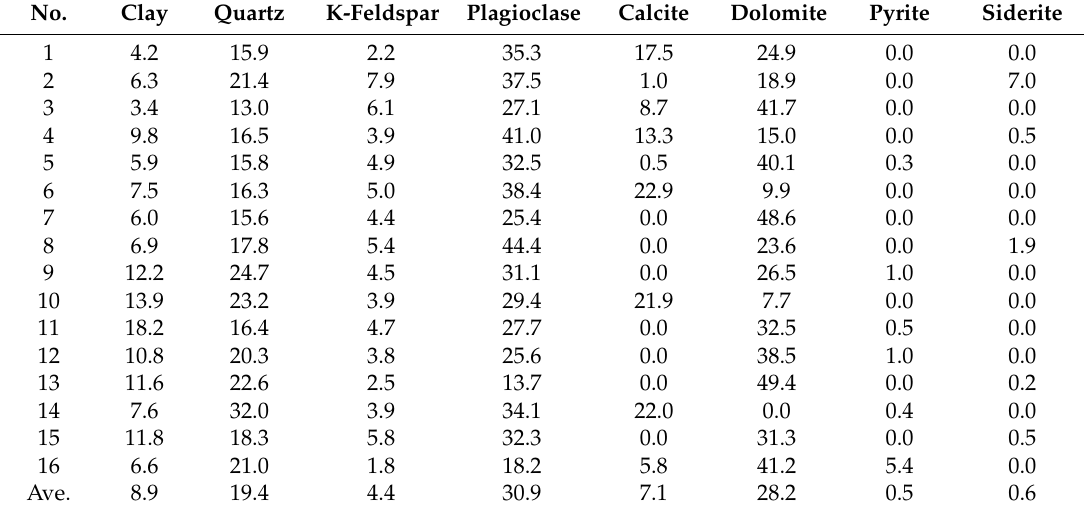
Table 1. Mineralogical composition (wt.%) of the sixteen core samples of tight oil